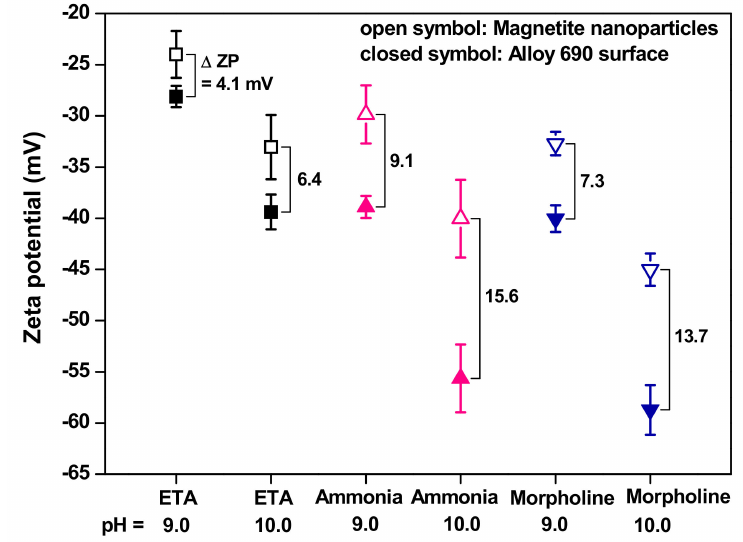
Figure 4. Relationship between the zeta potentials of magnetite nanoparticles and Alloy 690 surfaces at a pH of 9.0 and 10.0, depending on the pH agent at 25 ◦